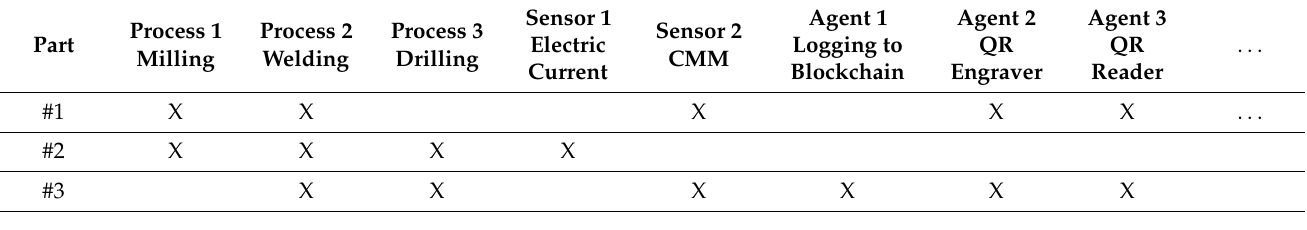
Table 3. Instance of enhanced binary clustering algorithm for CAPP.